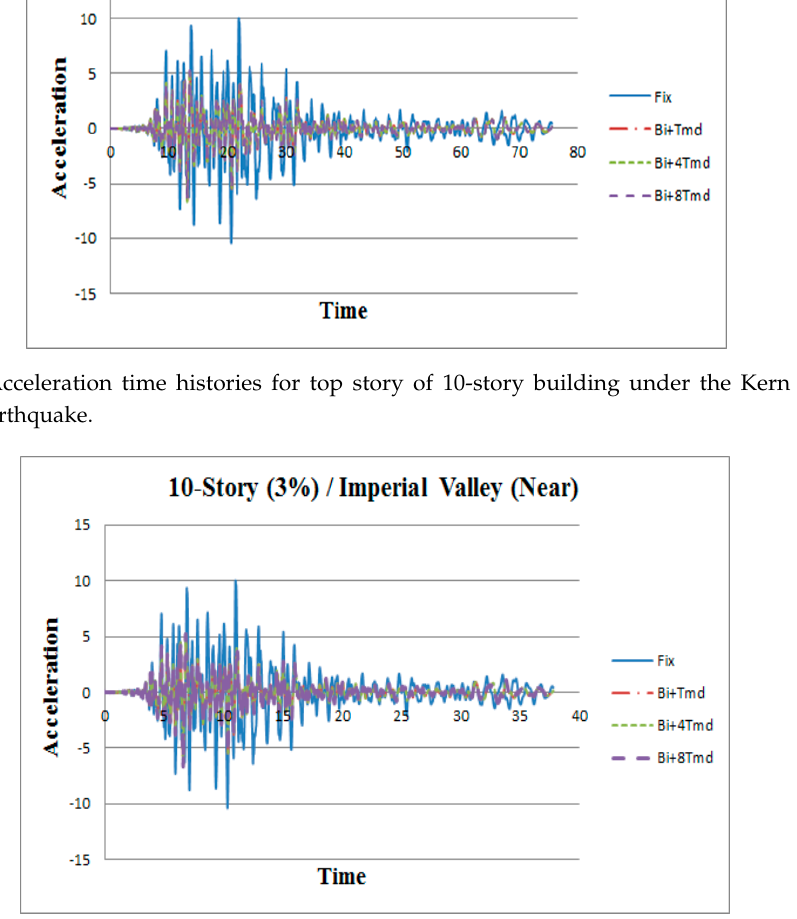
Figure 5. Acceleration time histories for top story of 10-story building under the Imperial Valley (near-fault) earthquake.